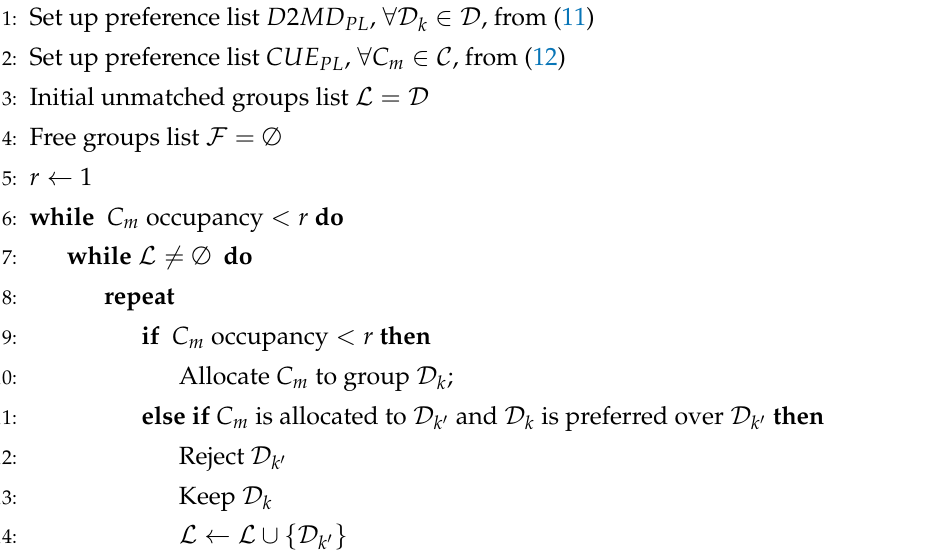
Algorithm 2 NOMA interference-based matching